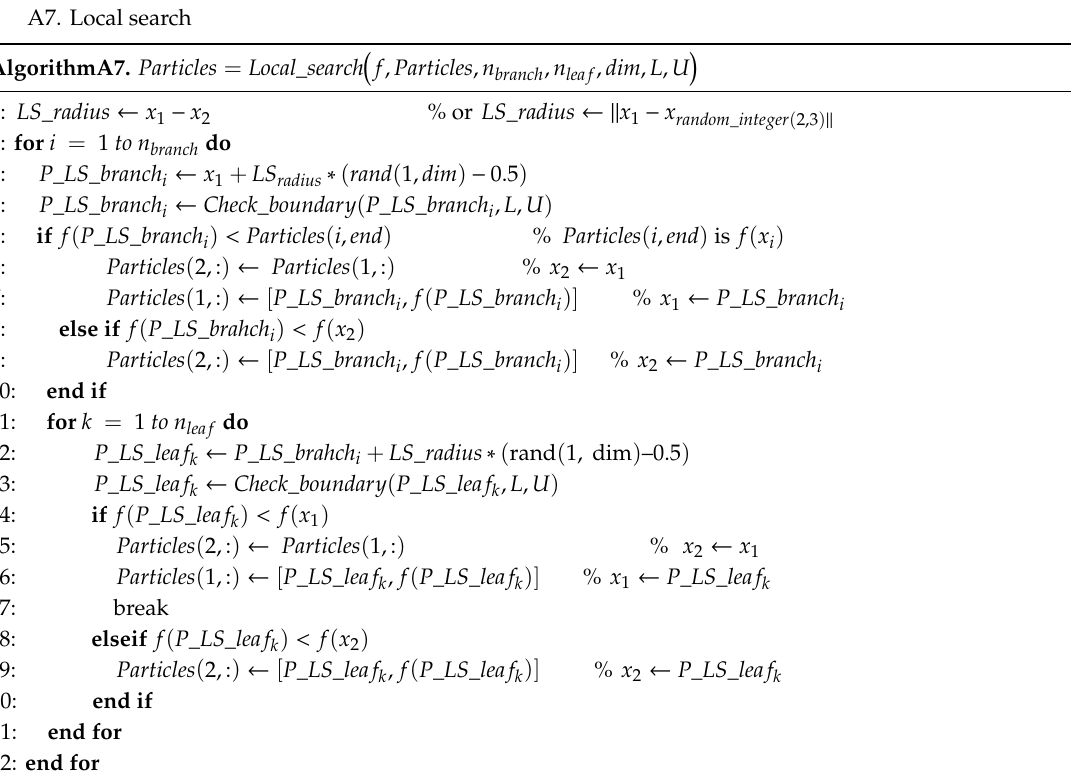
AlgorithmA7. Particles = Local _ search